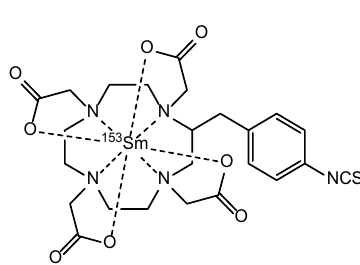
Fig. 8 Molecular structure of [ 153 Sm]Sm- p